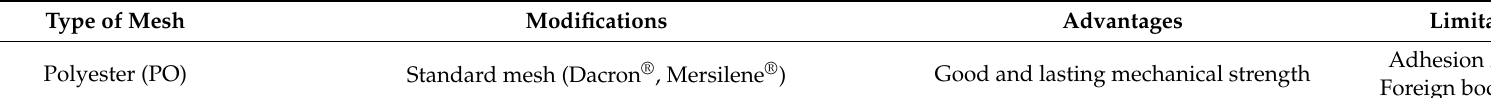
Table 1. Classification of the different types of polymeric meshes employed in hernia repair and the most representative modifications introduced. (PVDF, polyvinylidene fluoride; PLA, polylactic